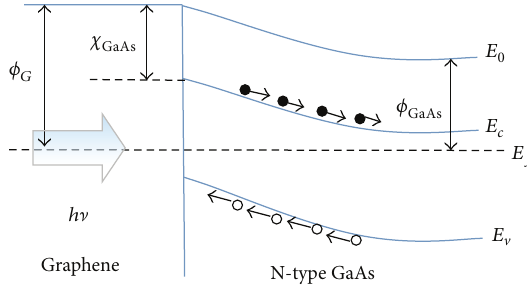
Figure 2: Energy diagrams of graphene n-GaAs solar